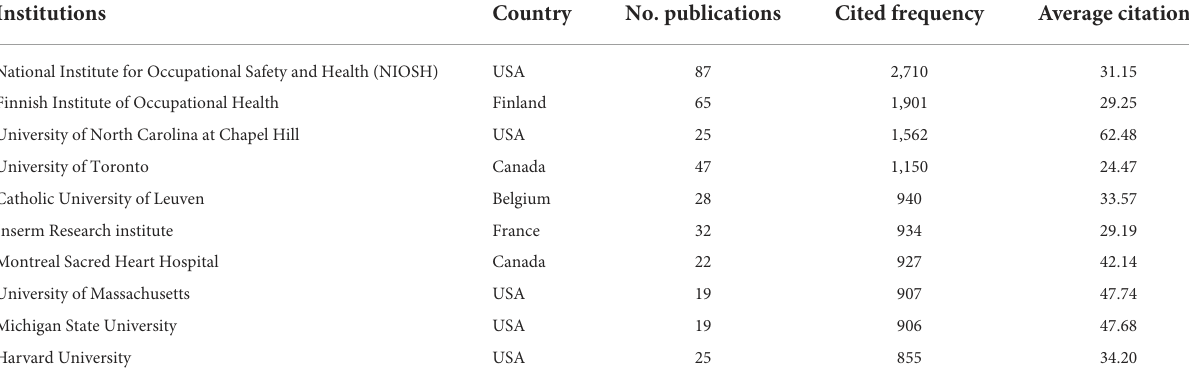
TABLE 7 Top 10 institutions on occupational diseases based on citations.